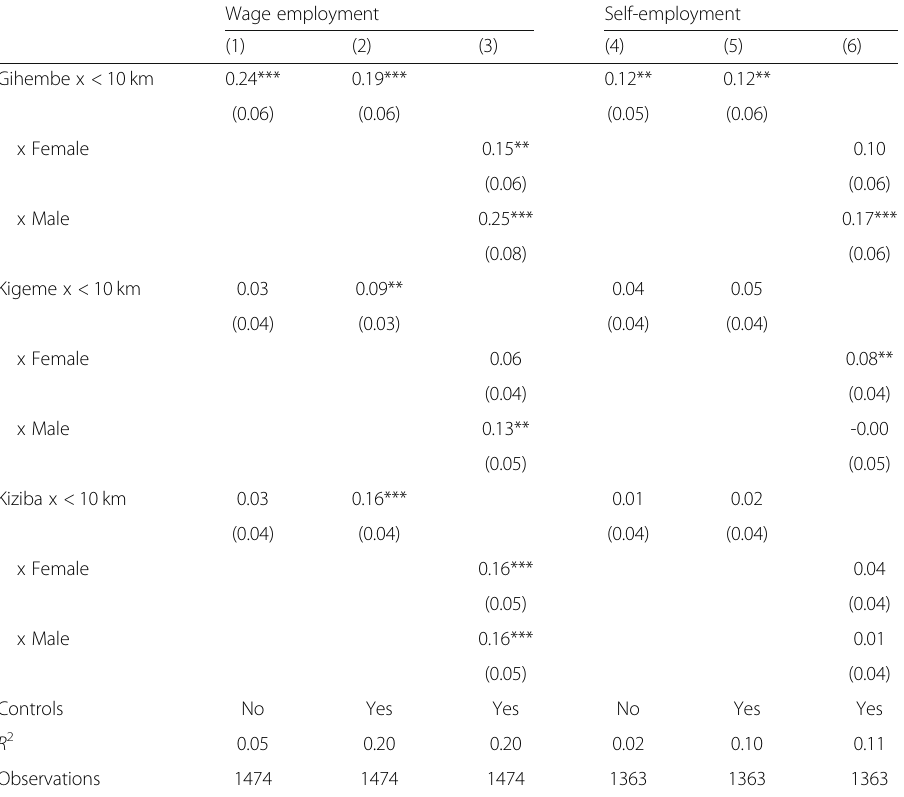
Table 9 Primary daily activity, by camp area Wage employment